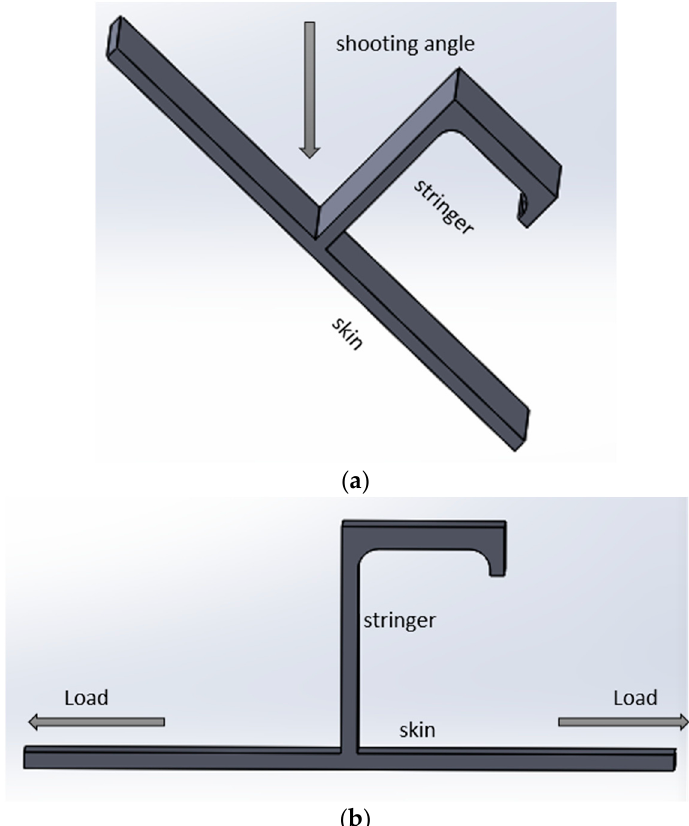
Figure 1. ( a ) Schematic diagram of X-ray non-destructive testing, ( b ) Schematic diagram of transverse tensile testing.